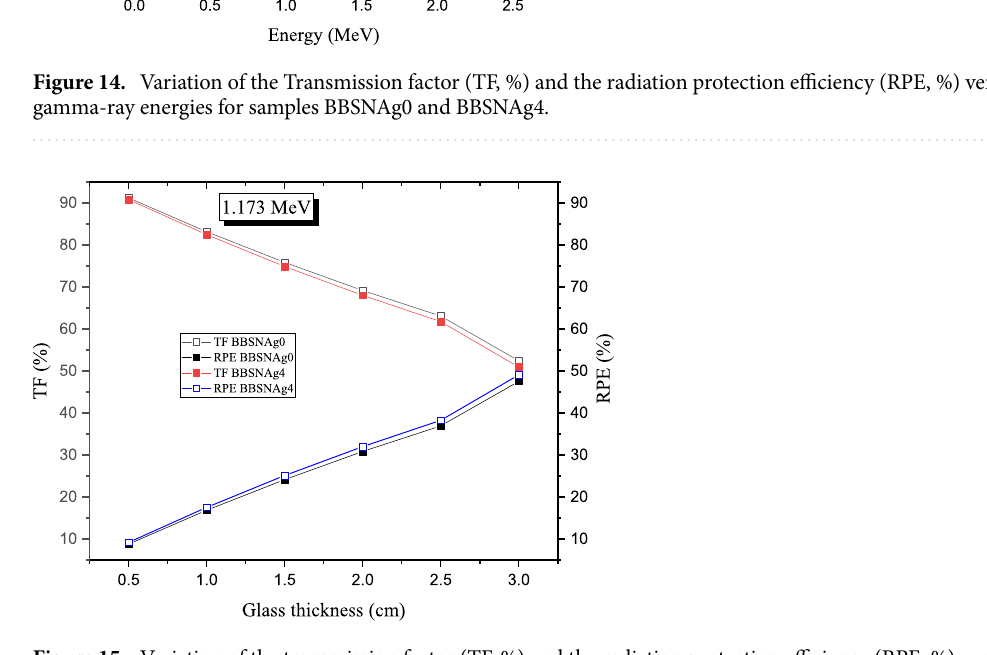
Figure 15. Variation of the transmission factor (TF, %) and the radiation protection efficiency (RPE, %) versus the glass thickness for samples BBSNAg0 and